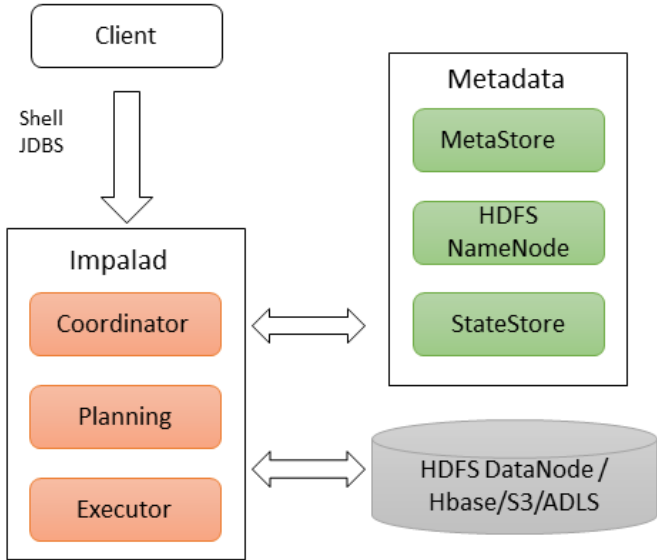
Figure 8. Impala architecture, using Hive Metastore to determine block and file